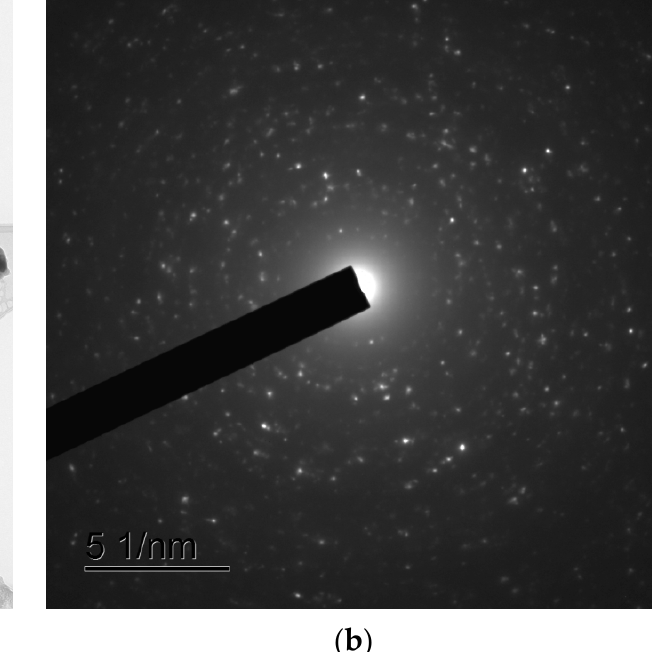
Figure 3. SEM images of the agglomerates ( a , c , e ) and of the synthesized powders ( b , d , f ): Ca 0.4 Zr 2 (MoO 4 ) 0.1 (PO 4 ) 2.9 ( a , b ), Na 0.5 Zr 2 (MoO 4 ) 0.5 (PO 4 ) 2 ( c , d ), Na 0.5 Zr 2 (WO 4 ) 0.5 (PO 4 ) 2 ( e , f ). Figures 4 and 5 present TEM images of the Ca 1-x Zr 2 (PO 4 ) 3-x (MoO 4 ) x powders with dif- ferent Mo contents (Figure 4) and of Na 0.5 Zr 2 (PO 4 ) 2.5 (XO 4 ) 0.5 powders, X = Mo, W (Figure 5). The Ca 1-x Zr 2 (PO 4 ) 3-x (MoO 4 ) x powders were large-grained and agglomerated strongly. The individual particle sizes ranged from ~50–100 nm to ~300 nm and didn’t depend on the Mo content (Figure 4). The Na 0.5 Zr 2 (PO 4 ) 2.5 (XO 4 ) 0.5 powders were more finely dispersed and agglomerated. The particle sizes ranged from ~20–30 nm to ~50–100 nm (Figure 5). The agglomerate sizes were ~0.2–0.3 µ m. All powders had crystalline structure (Figures 4b,d,f and 5b,d,e,f).